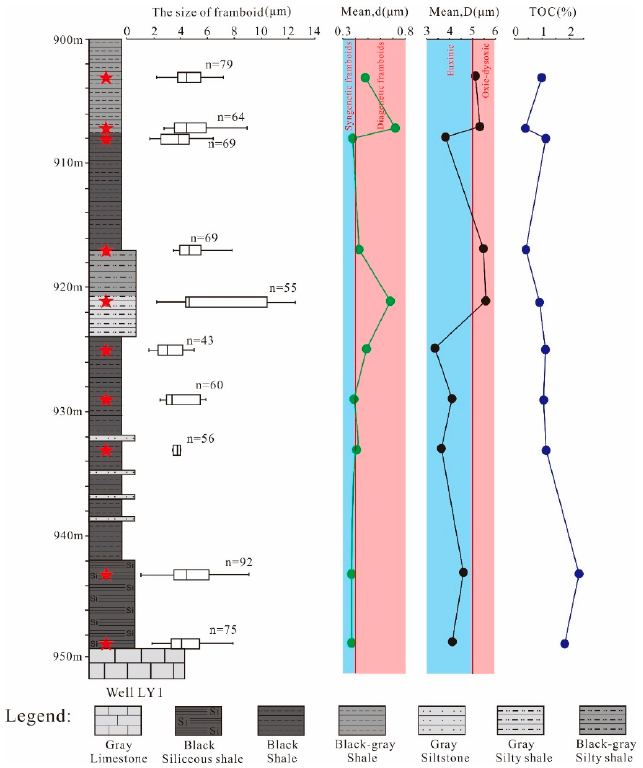
Figure 7. Size distribution of pyrite framboids, mean, D, mean, d, and TOC in the well LY1 shales.